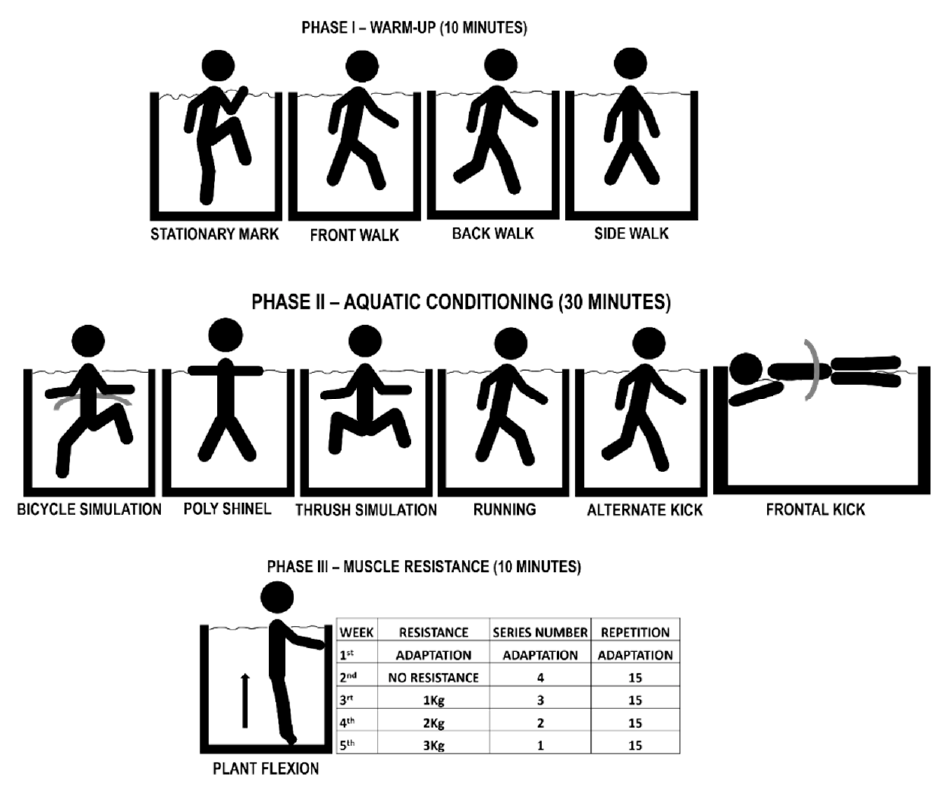
Figure 3. Intervention Group Protocol.